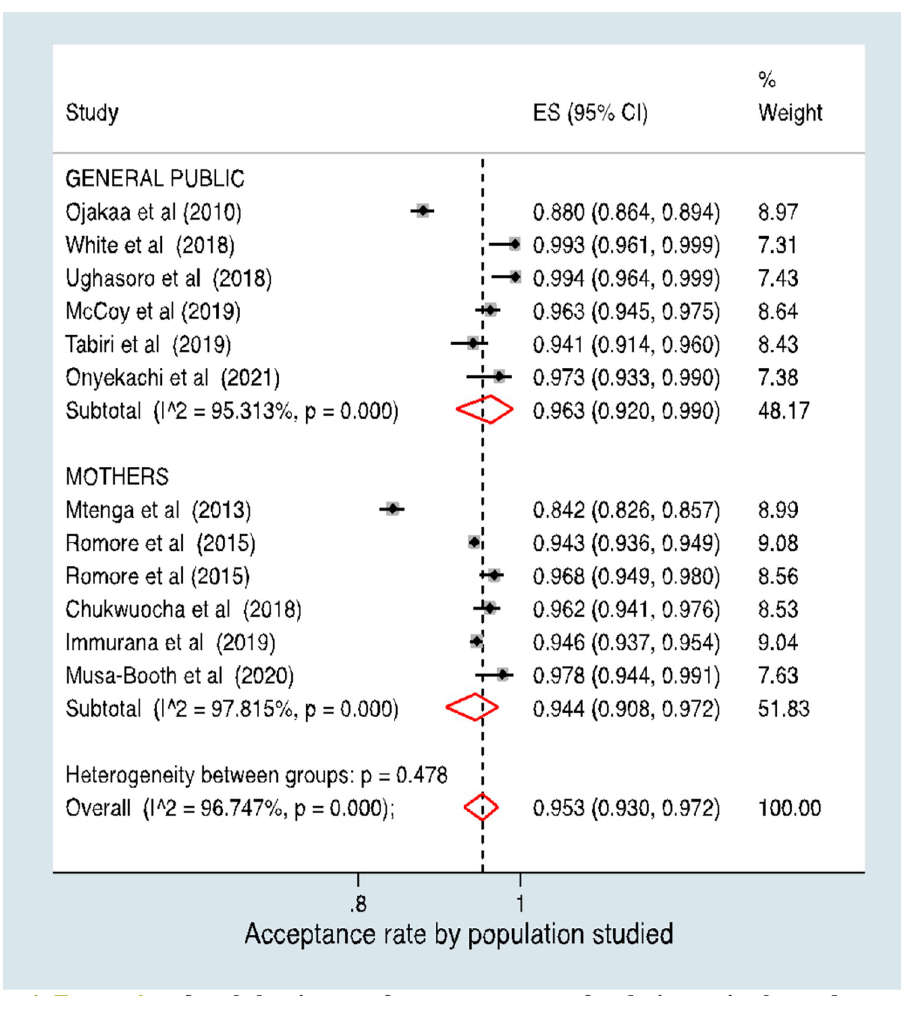
Fig 4. Acceptance of malaria vaccine by study